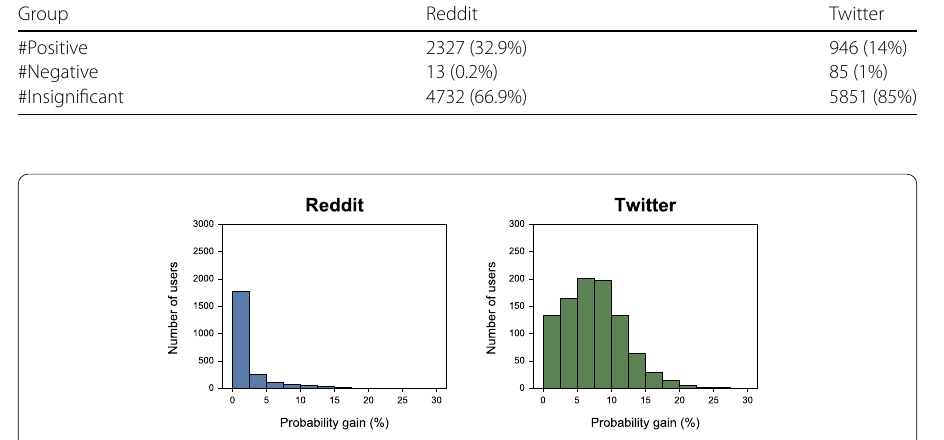
Figure 4 Gain of the topic repeat probability due to the community feedback (cid:7) p i for the positive users